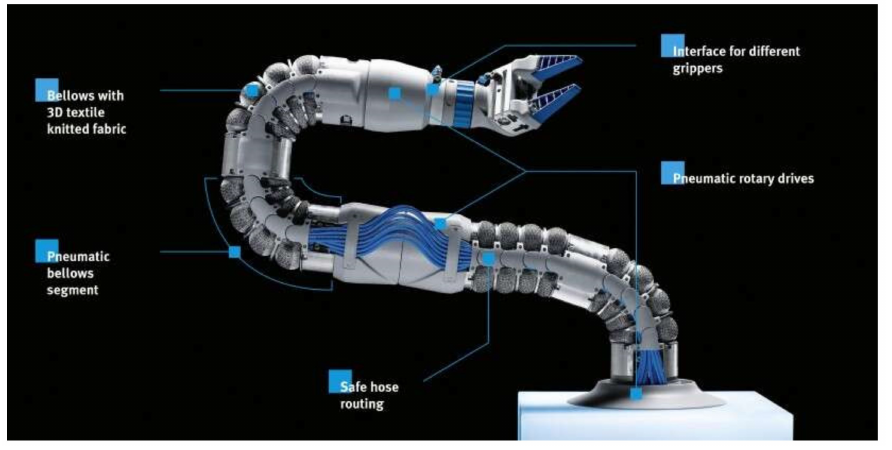
Figure 7. BionicSoftArm (2019)